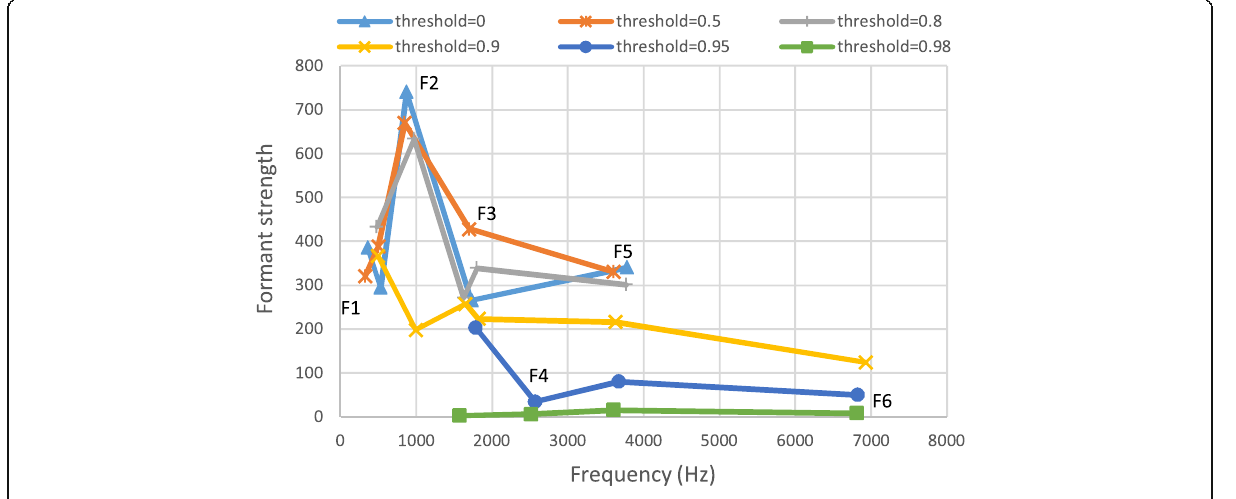
Fig. 2 Formants obtained for different condition on the root of LPC